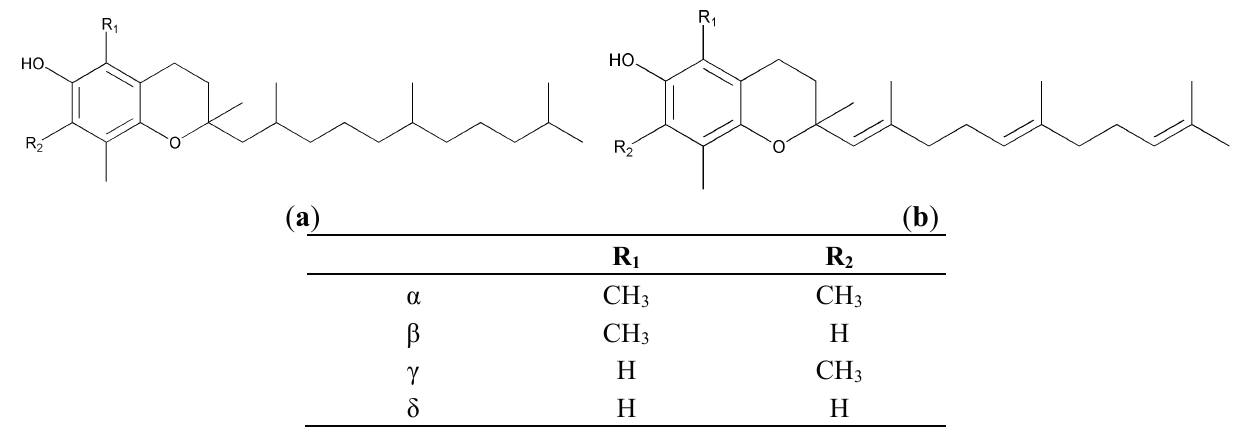
Figure 4. Structures of tocols. ( a ) Tocopherols; ( b )